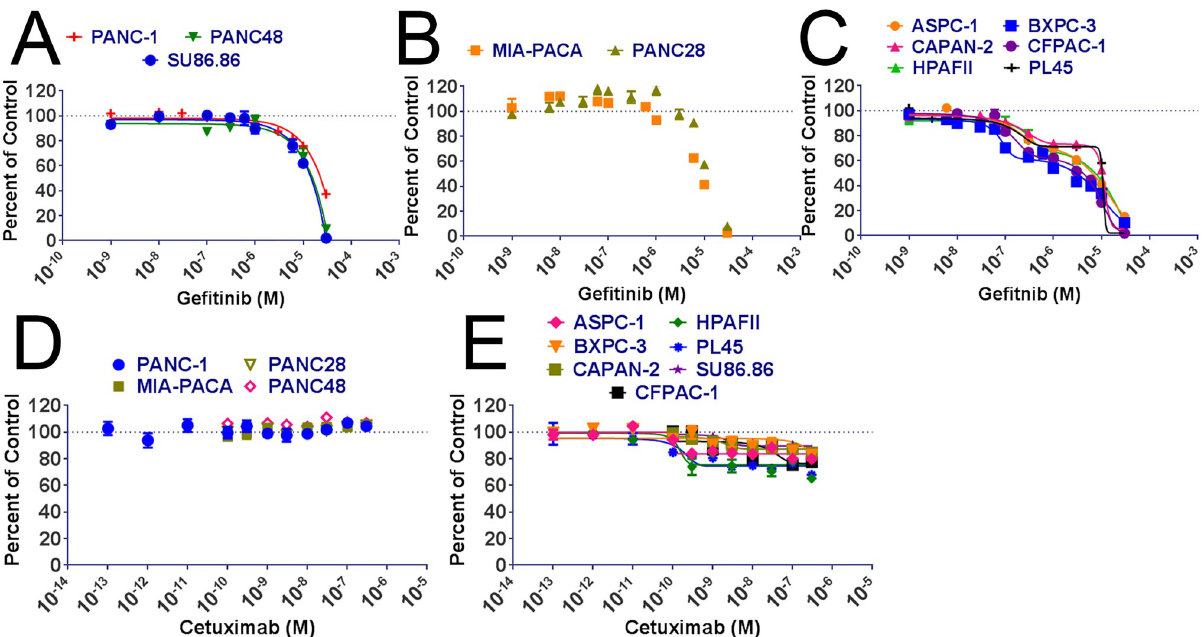
Fig 1. EGFR inhibitor sensitivity on selected pancreatic adenocarcinoma cell lines. PDAC cells were treated with the indicated concentrations of gefitinib for 6 days and cell viability was measured by MTT assay. (A) Gefitinib insensitive cells. Monophasic curves were generated for gefitinib insensitive MTT data. (B) Gefitinib activated cells. No curve was generated for gefitinib activated cells; (C) Gefitinib sensitive cells. A biphasic curve was generated for gefitinib sensitive MTT data. PDAC cells were treated with the indicated concentrations of cetuximab for 6 days and cell viability was measured by MTT assay. (D) Cetuximab insensitive cells. No curve was generated for cetuximab insensitive cells. (E) Cetuximab sensitive cells. Monophasic curves were generated for cetuximab sensitive MTT data. Assays were completed in triplicate.